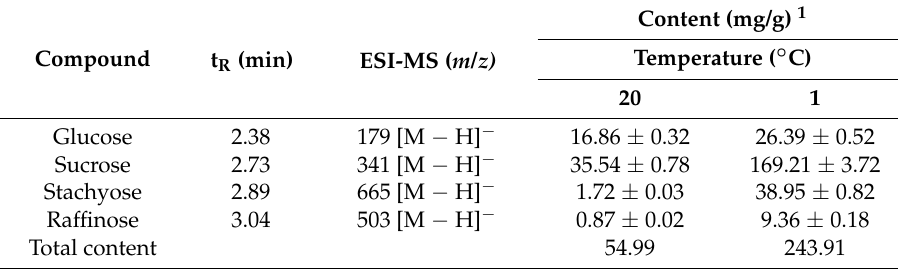
Table 6. HPLC parameters, electrospray ionization mass spectrometry (ESI-MS) data and the content of simple sugars (mg/g DW ± SD) in D. palmatum herb under different temperatures of cultivation.